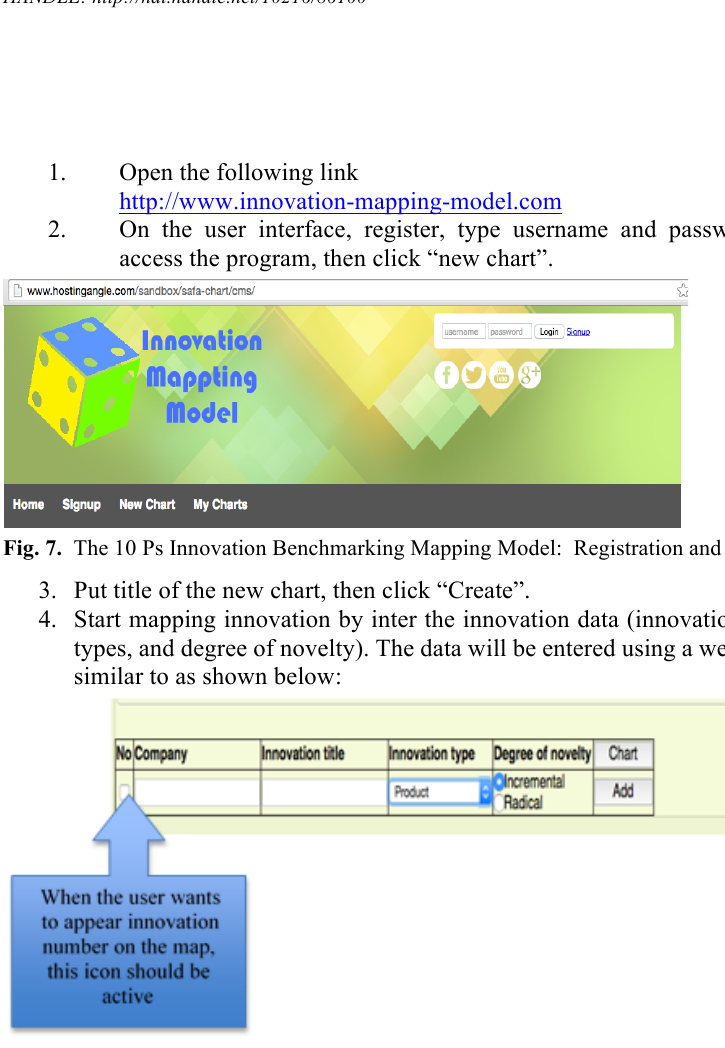
Fig. 8. Illustration of the Data Input for Each Innovation When “add” is pressed (and all fields are filled), the data will be saved in the database, and will be shown in the table